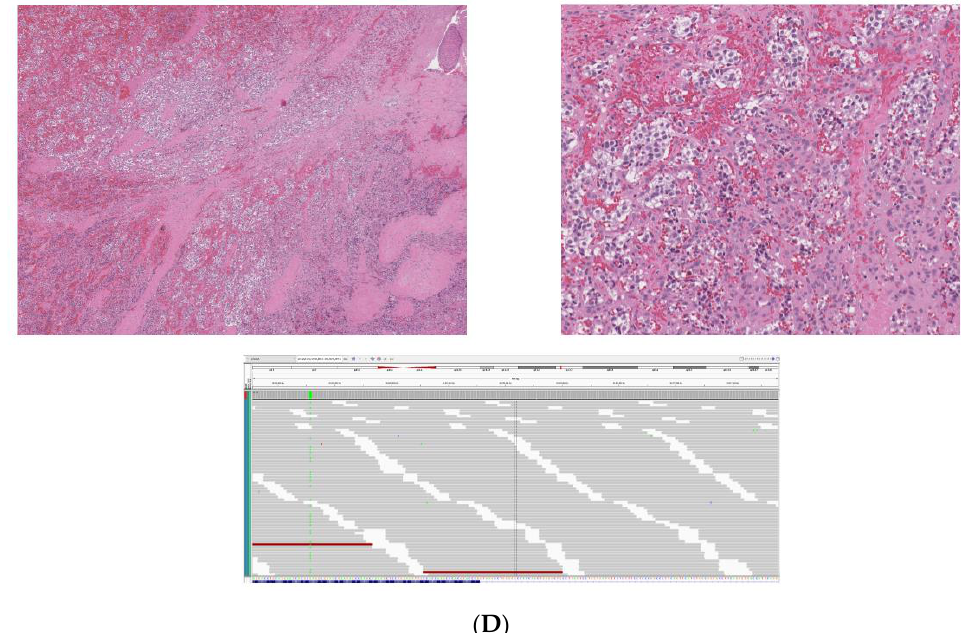
Figure 3. Case examples of genomic alterations associated with CA-Pheo and CA-Para patients. ( A ). FGFR1 mutation- driven CA-Pheo. Metastatic adrenal Pheo to the liver in a 57-year-old Latino female (case number CA-Pheo45). ( A ) (upper left) shows a low magnification of the metastatic lesion with liver tissue to the left (hematoxylin and eosin X 50). In the higher magnification in ( A ) (upper right) to the upper right, the pleomorphic CA-Pheo is seen with micro focal necrosis (hematoxylin and eosin X 200). In ( A ) (lower center) the only genomic alteration in this sporadic Pheo was an activating mutation in the FGFR1 gene (N546K) seen in the International Genome Viewer (IGV) plot This CA-Pheo was MSI stable and had a tumor mutation burden of 4 mutations/MB of sequenced DNA. In ( B ). RICTOR amplification as a potential target in CA-Pheo (case number CA-Pheo10) is shown. Sporadic clinically advanced Pheo in a 45-year-old Caucasian man. Comprehensive genomic profiling of the primary tumor revealed amplification of the RICTOR , CCND2 , FGF23 and FGF6 genes along with short variant mutations in ATM L2211fs*4 and CTNNB1 S45P. ( B ) (upper left) shows a low magnification view of the primary tumor revealing geographic necrosis (hematoxylin and eosin X 50). ( B ) (upper right) shows a higher magnification of the CA-Pheo showing high grade nuclear pleomorphism (hematoxylin and eosin X 200). The copy number plot shown in ( B ) (lower center) highlights the amplification of the RICTOR gene which is localized at chromosome 5p 13.1. ( C ) describes a TSC2 inactivating mutation in a CA-Pheo with germline MEN1 mutation (case number CA-Pheo42). This case is clinically advanced Pheo of the left adrenal in a 71-year-old African American woman. The primary tumor in ( C ) (right) was 8 cm in largest diameter, featured focal necrosis and lymphovascular invasion (hematoxylin and eosin X 200). This tumor was negative for PD-L1 expression on immunohistochemistry (Dako 22C3 antibody). Comprehensive genomic profiling revealed short variant mutations in TSC2 Q166* as seen in the IGV plot in ( C ) (upper left). There was also a CTNNB1 loss exons 2-3 and a predicted to be germline MEN1 splice site 928-9_942del24 mutation seen in the IGV plot in ( C ) (lower left). ( D ) describes an NF2 mutation-driven CA-Para (case number CA-Para78) that presented as a recurrent clinically advanced Para of the right ear canal in a 35-year-old Caucasian man that invaded the temporal bone. Comprehensive genomic profiling revealed an NF2 E463K base substitution mutation and no other genomic alterations. The tumor mutation burden (TMA) was low at 2 mutations per Mb of sequenced DNA and the tumor was MSI Stable. The low magnification image in ( D ) (upper left) shows the CA-Para with fibrous stroma and extensive necrosis (hematoxylin and eosin X 5). The higher magnification image ( D ) (upper right) shows individual cell necrosis, hemorrhage and fibrosis (hematoxylin and eosin X 200). The IGV image in ( D ) (lower center) demonstrates the NF2 inactivating base